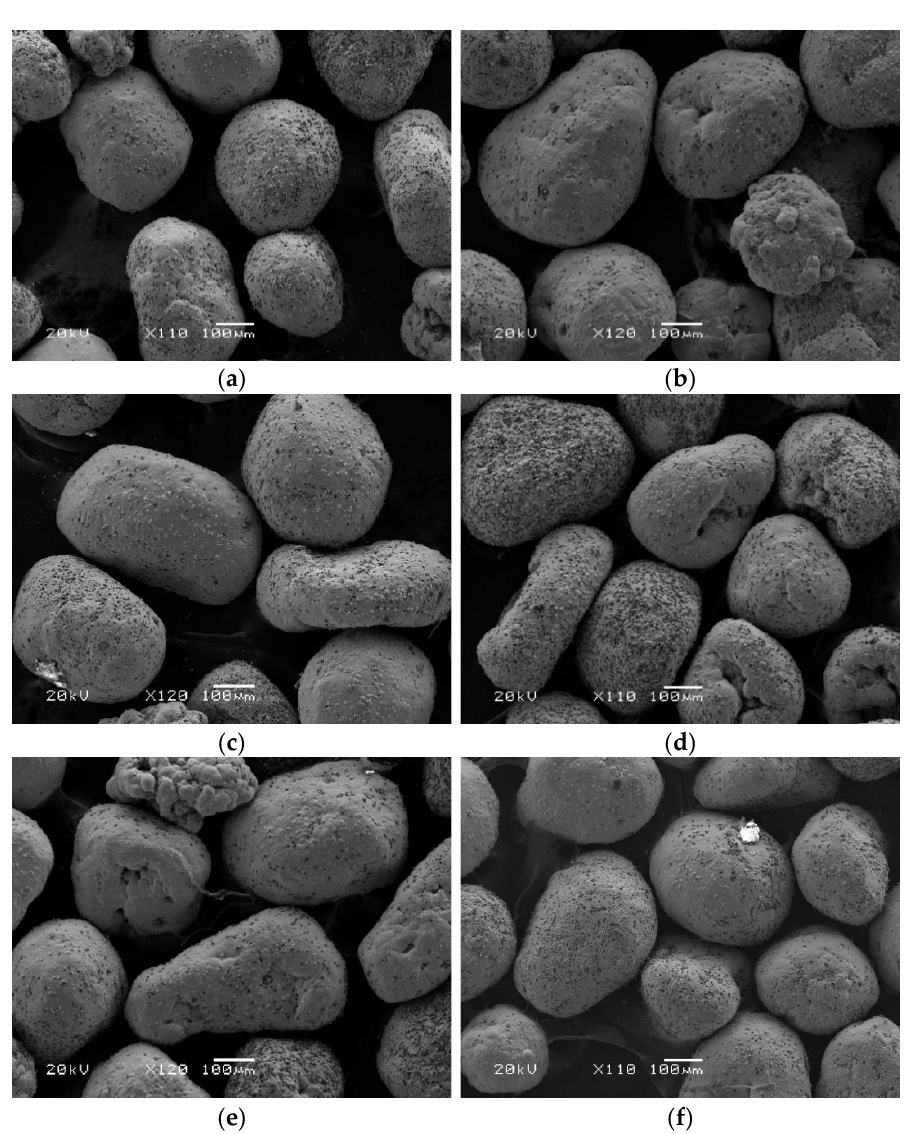
Figure 14. Surface topography of magnetic abrasives: ( a ) after UAMAF for 10 min, ( b ) after UAMAF for 20 min, ( c ) after UAMAF for 30 min, ( d ) after MAF for 10 min, ( e ) after MAF for 20 min, ( f ) after MAF for 30 min.